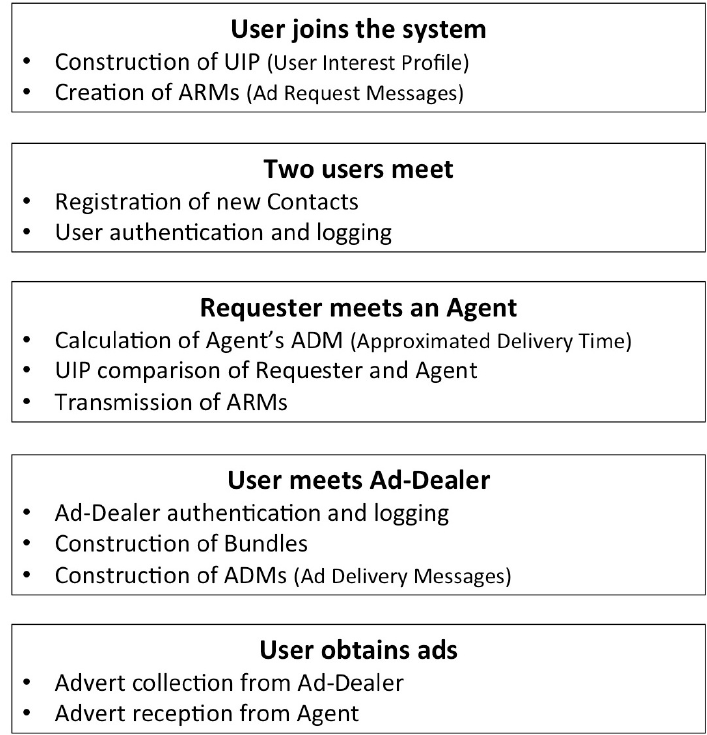
Figure 1. System sub-protocols and their corresponding